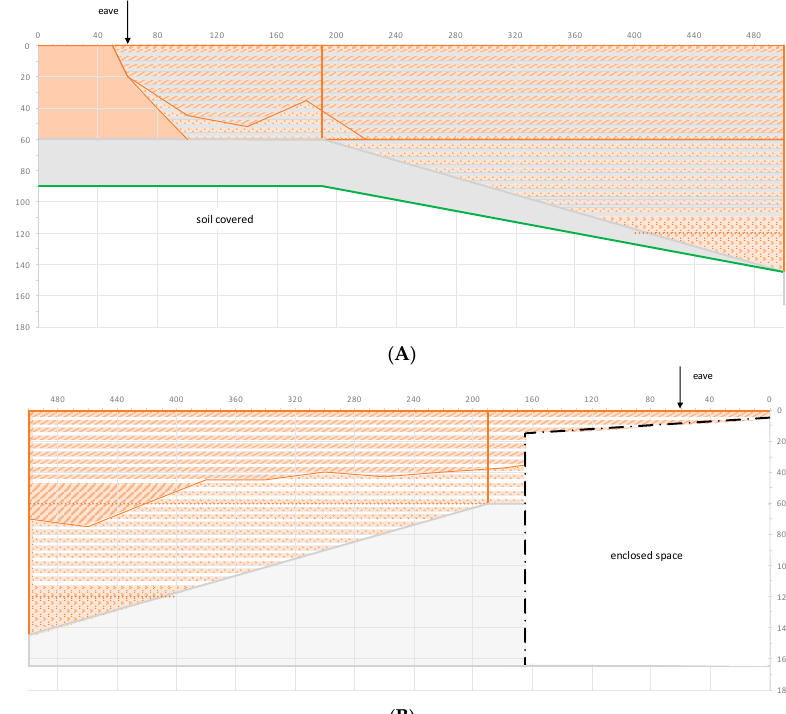
Figure 16. Schematic representation of the observed decay of wall 3: ( A ) eastern face; ( B ) western face. For the legend, see Figure 13.